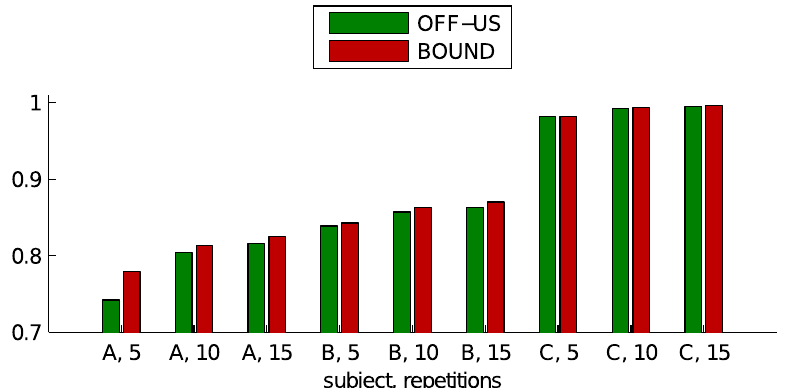
Figure 5. Bar graph showing the performance, measured in AUC, on the test. The classifier OFF-US is trained unsupervisedly on the test set. The BOUND is trained supervisedly on the test set without regularization.